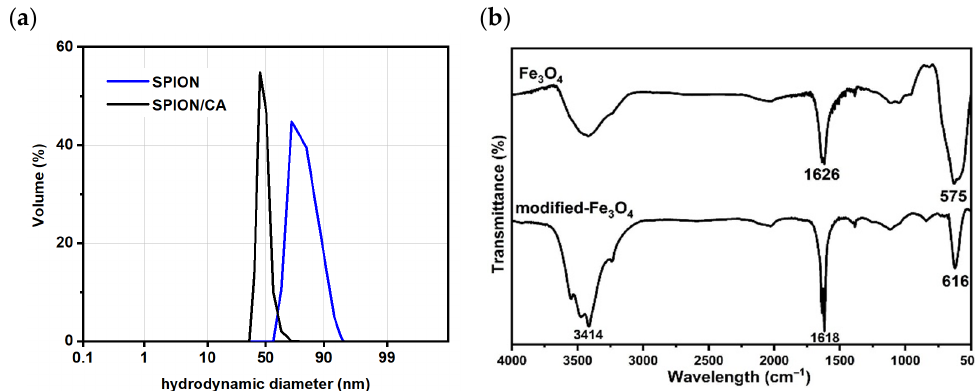
Figure 5. ( a ) DLS analysis ( b ) FT-IR analysis of SPIONs before and after modification with citrates.